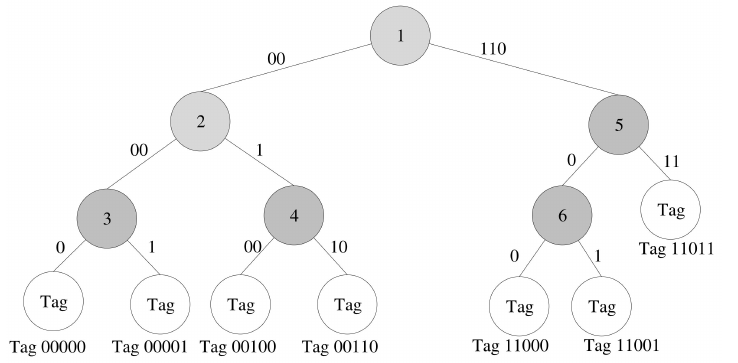
Figure 1. Example of k-tree. To be clearer, S n of a node n is labeled in the link connecting its parent. Thus, S n of the root node is ∅ (empty